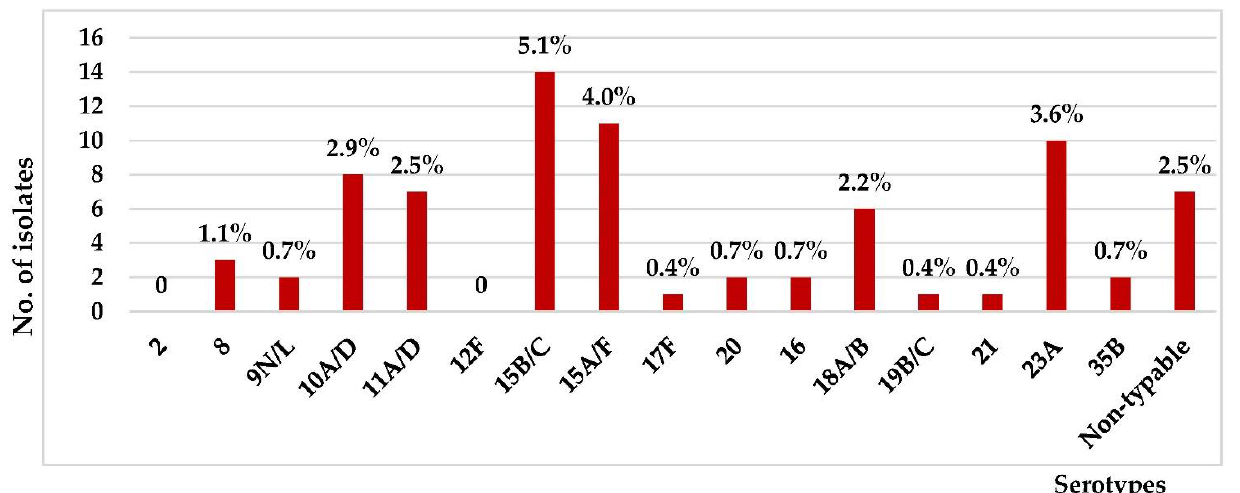
Figure 2. Non-PCV15 serotype distribution of S. pneumoniae -causing IPD, central Thailand, all ages, 2012 – 2016 ( n = 77).